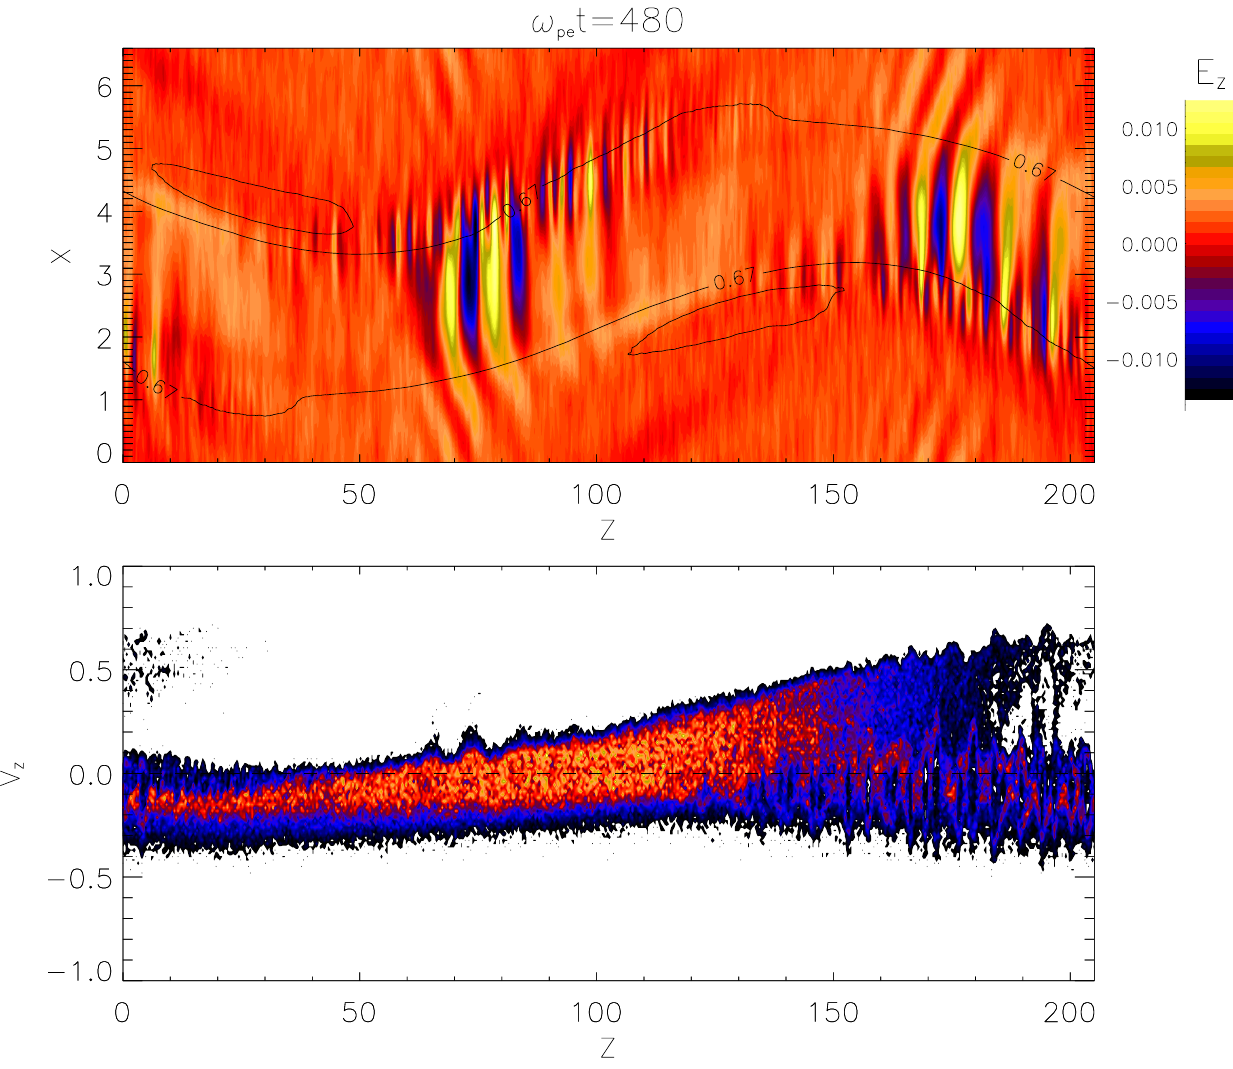
Fig. 5. Parallel electric field and parallel electron phase space at ω pe t = 480 ( δB/B = 0 . 05). The electric field is shown in the 2-D simulation box with colour-coded amplitude and with density contours overlaid; the “0.67” line coarsely defines the middle of the region of density variation along the X direction. The bottom panel is the electron velocity distribution function in the parallel velocity direction and along the magnetic field. Each dot corresponds to a particle in this coordinate space. Only electrons located in the lower gradient region have been